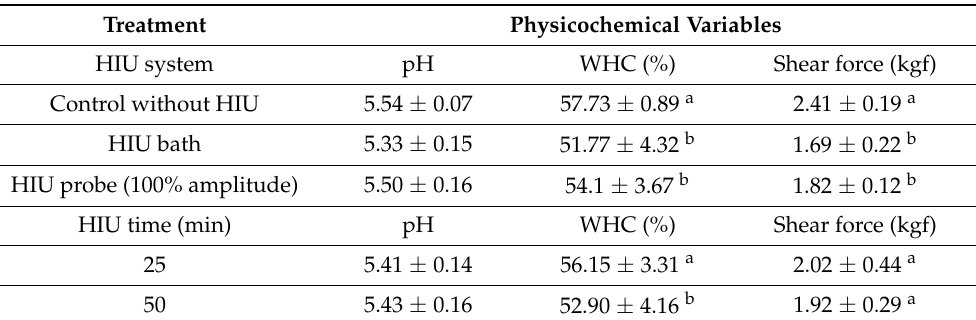
Table 2. Effect of HIU system and HIU time factors on pH, water holding capacity (WHC,%), and shear force (kgf) of bovine Longissimus lumborum